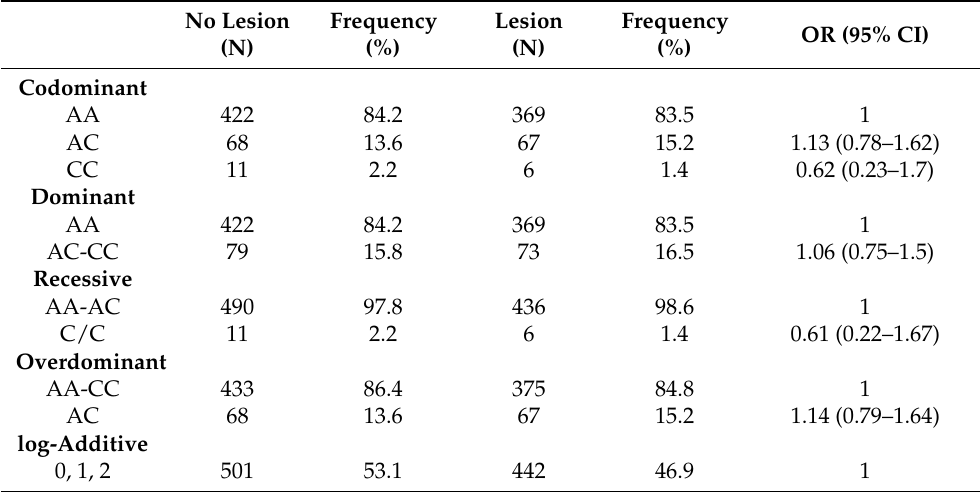
Table 1. Frequencies of the rs41976219 genotypes in healthy cows and cows with PTB-associated lesions and odds ratios (ORs) for each genetic model.